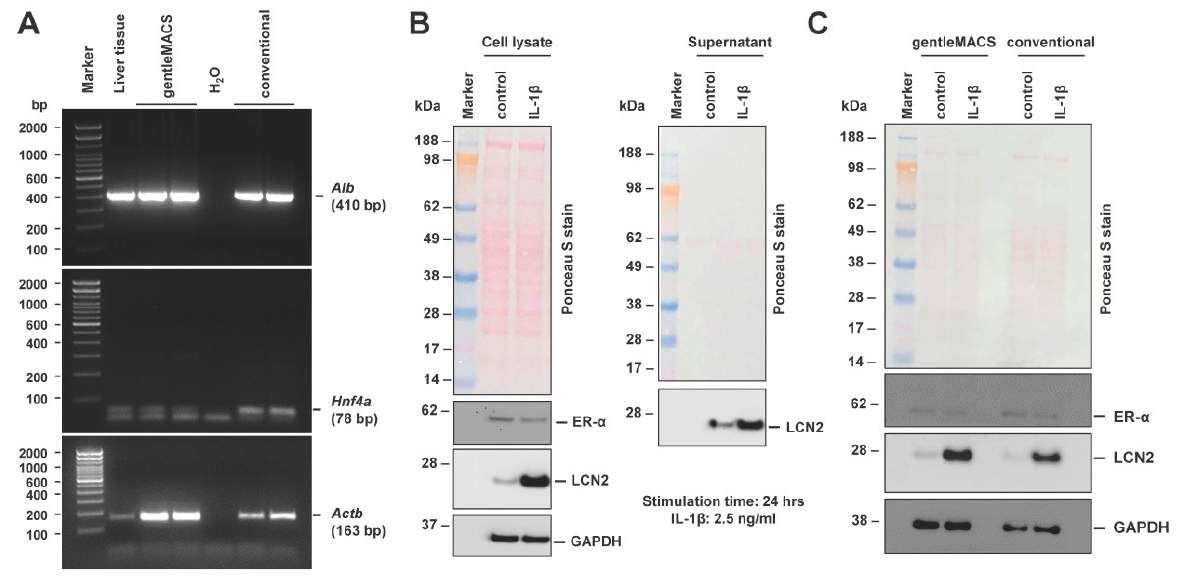
Figure 6. Biochemical features of hepatocytes isolated with the gentleMACS Perfusion Technology. ( A ) Comparative analysis of Albumin ( Alb ) and hepatocyte nuclear factor 4 α ( Hnf4a ) mRNA isolation procedure. The RNA was subjected to a standard RT-PCR using the following primers: Alb-for: 5 ′ -ggt ctc atc tgt ccg tca gag-3 ′ , Alb-rev : 5 ′ -gga aga cat cct tgg cct cag-3 ′ , Hnf4a-for: 5 ′ -cca aga